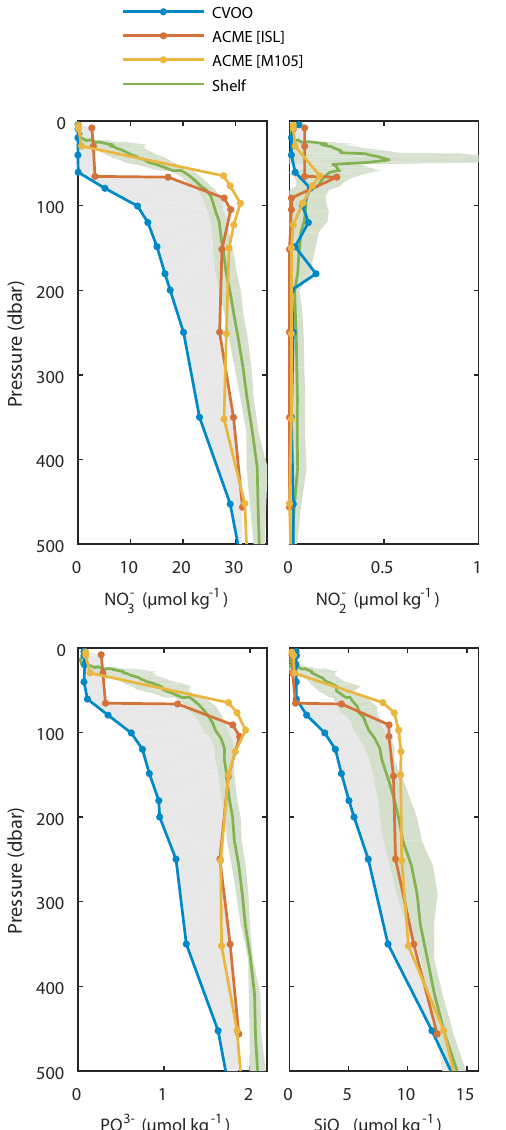
Figure 4. Discrete bottle data for nutrients from the different ACME surveys. The gray shading illustrates the anomaly of the ACME (ISL) with respect to the regional background situation (CVOO).